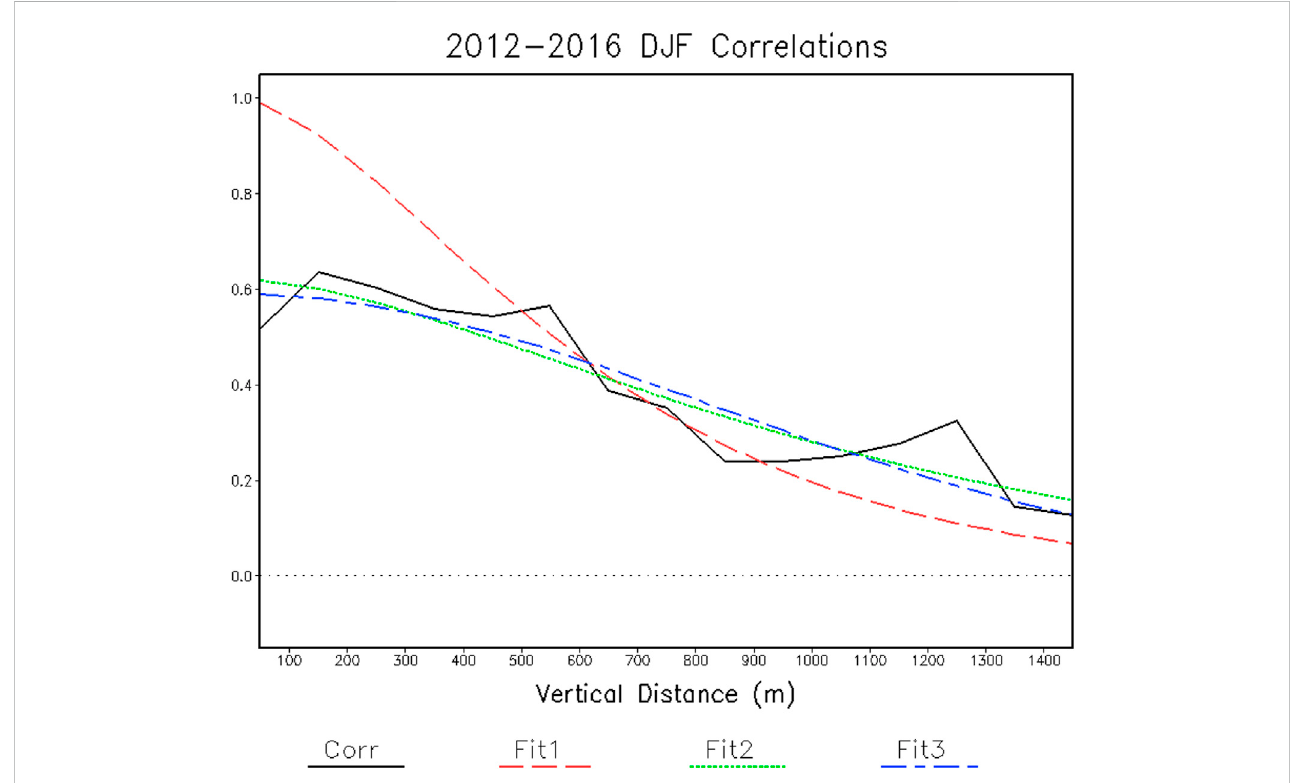
FIGURE 5 Daily snow depth increment correlations as a function of vertical separation distance. The observed correlations, Corr, and the indicated model fi ts are shown.